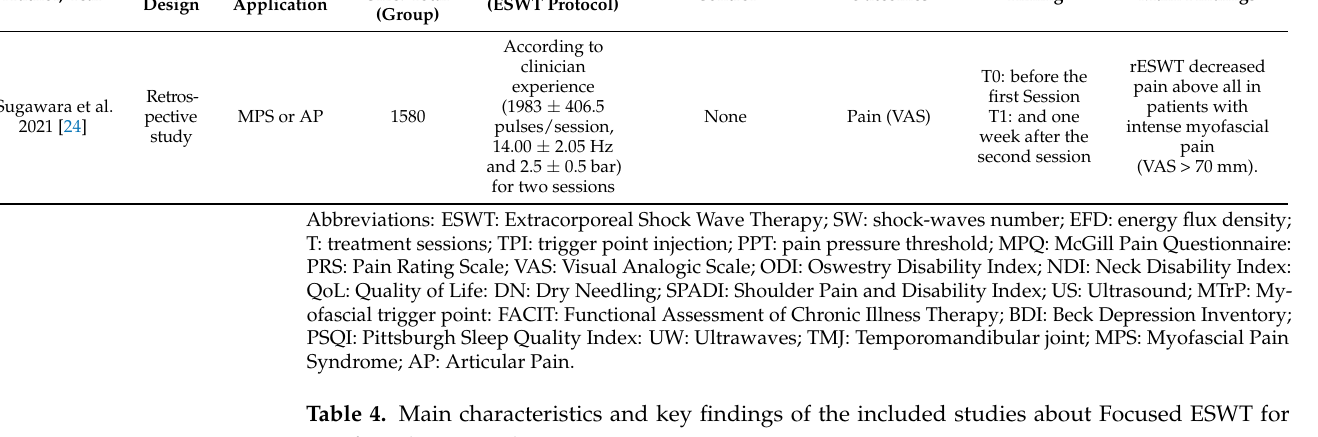
Table 4. Main characteristics and key findings of the included studies about Focused ESWT